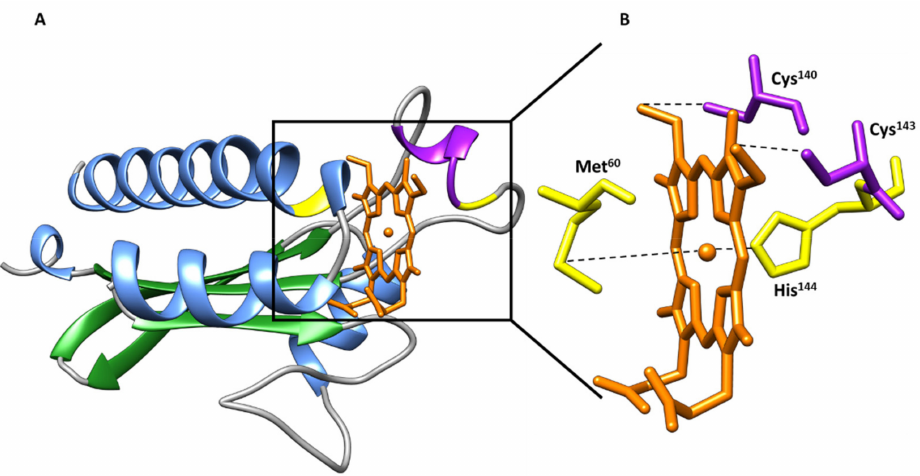
Figure 8. ( A ) Structure of the heme pocket region of MCP GSU0935 sensor domain from G. sulfurre- ducens and ( B ) schematic representation of heme group (in orange) with its binding residues (axial ligands—Met 60 and His 144 —and cysteine residues from the heme binding motif—Cys 140 and Cys 143 ). The β -strands and α -helices are represented in green and blue, respectively. The heme-binding site is represented in purple and the axial ligands in yellow.